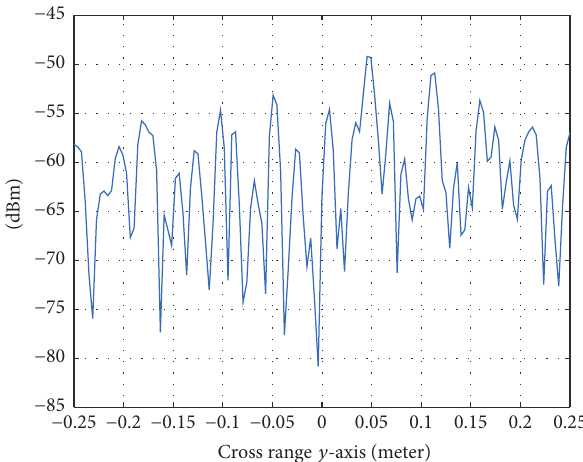
Figure 12: Final tomographic image reconstruction for irregular complex target geometry produced by the algorithm, isolating the effect of the weak